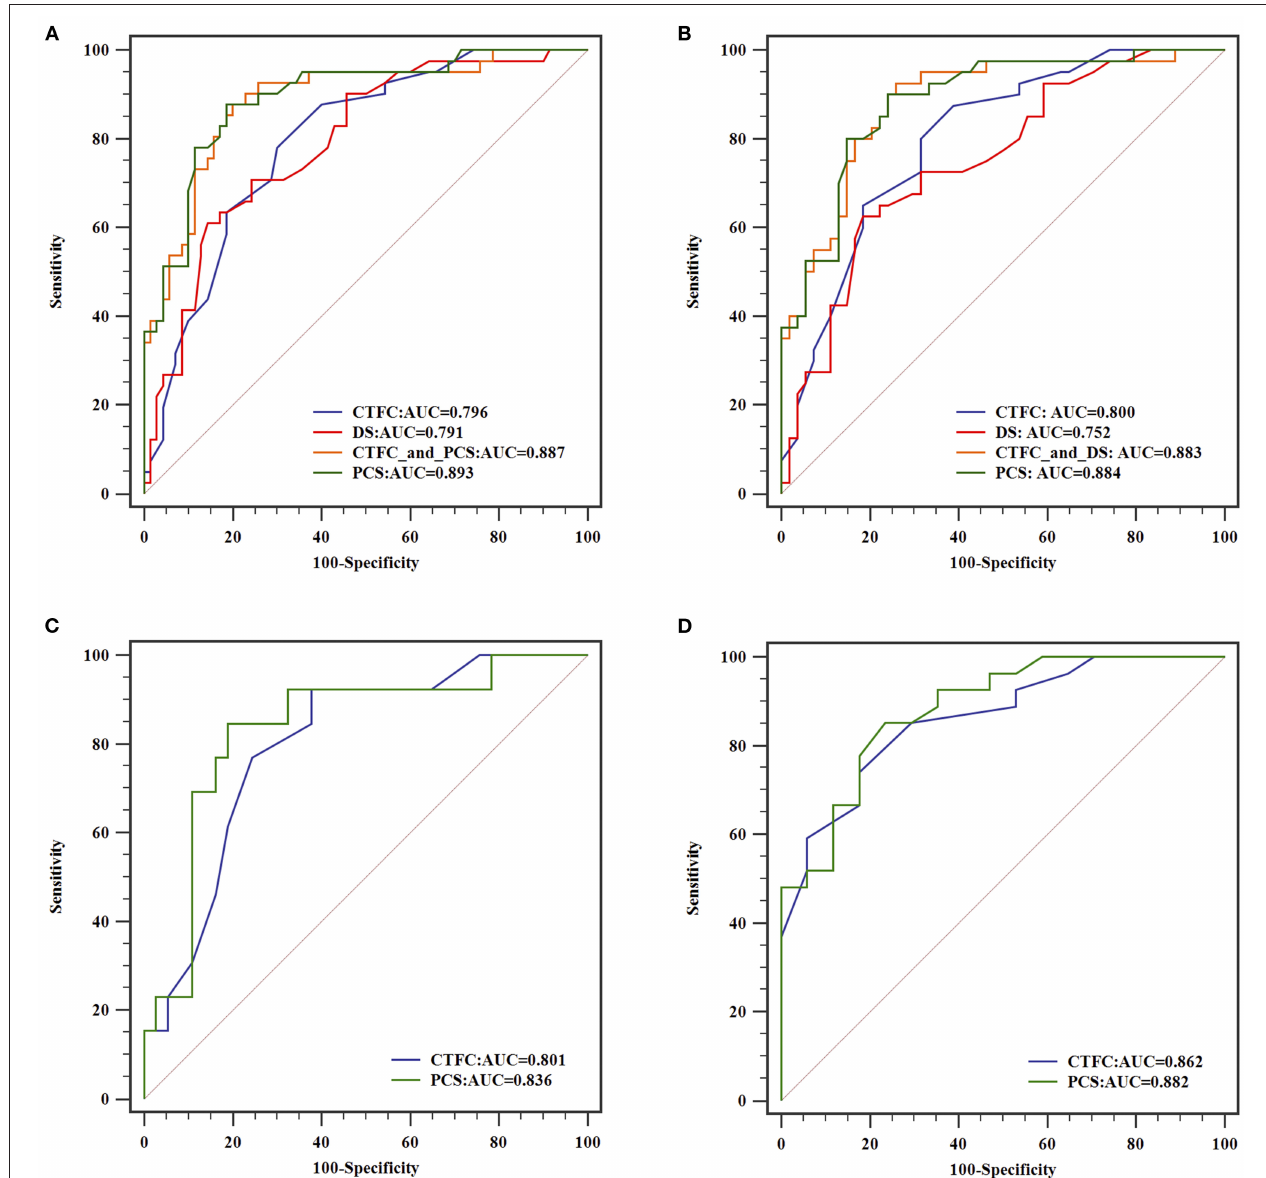
FIGURE 4 | ROC curves of different models for diagnosing flow-limiting stenosis. From (A–D) , analysis of all coronary arteries, arteries with DS ≥ 50% stenosis, arteries with intermediate and severe stenosis were illustrated, respectively.